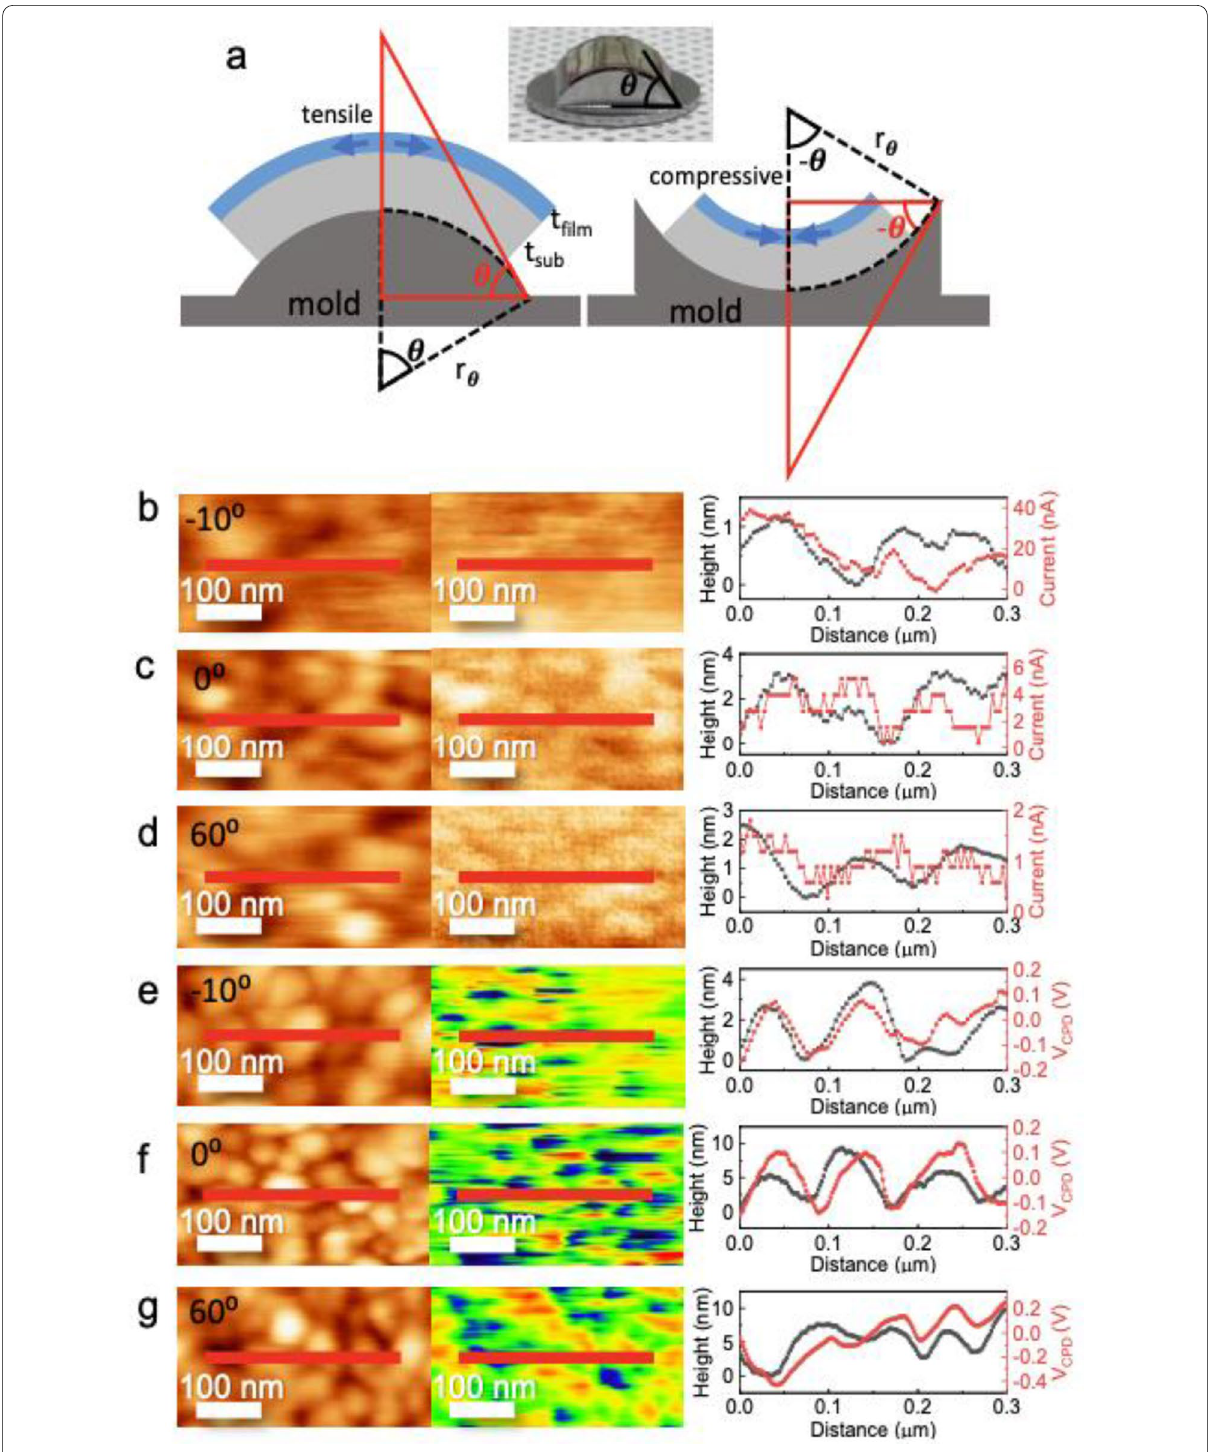
Fig. 5 Grain-boundary-related CPD and current mapping for the conducting HfO 2- x thin film during bending. a Schematics of flexible thin films on convex (left) and concave (right) molds and the corresponding tensile and compressive strain, respectively. A photograph of the bent HfO 2- x thin film is shown in the middle. Topographies (left) and current mapping images (middle) obtained at b -10°, c 0°, and d 60°, and topographies (left) and CPD mapping images (middle) obtained at e -10°, f 0°, and g 60°. Line profiles (right) are shown for the red